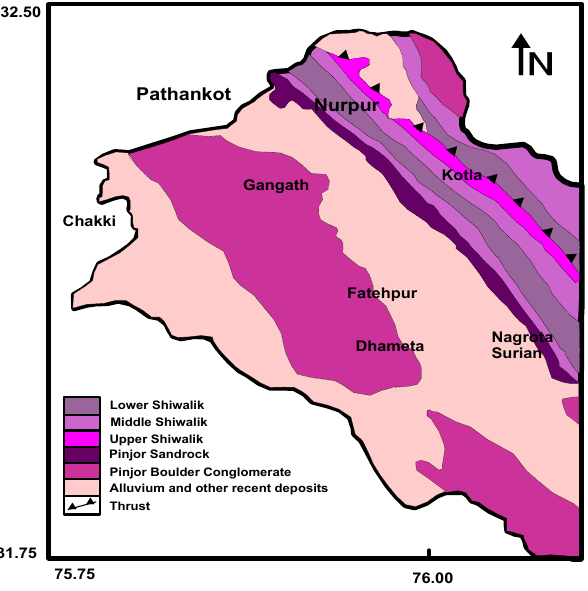
Fig.1: Map of Nurpur and adjoining area showing geological divisions and the Fig. 1. Map of Nurpur and adjoining area showing geological divi- Jawalamukhi thrust crossing the area. sions and the Jawalamukhi thrust crossing the